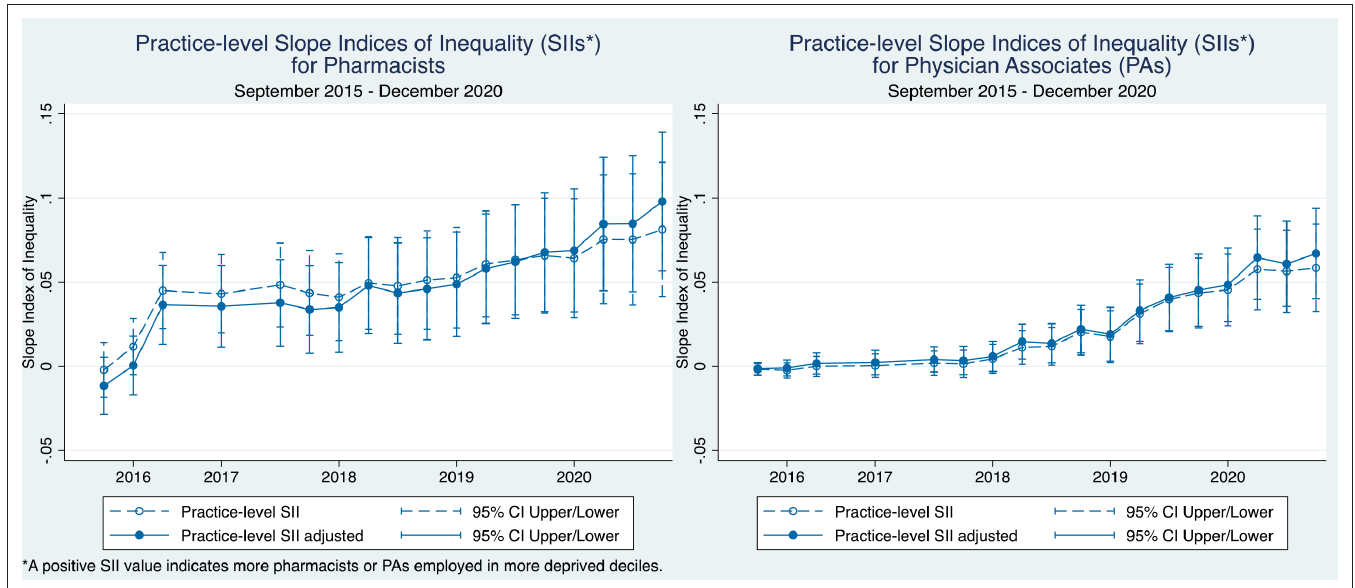
Figure 4 Practice- level slope indices of inequality (SIIs) over time for pharmacists and physician associates